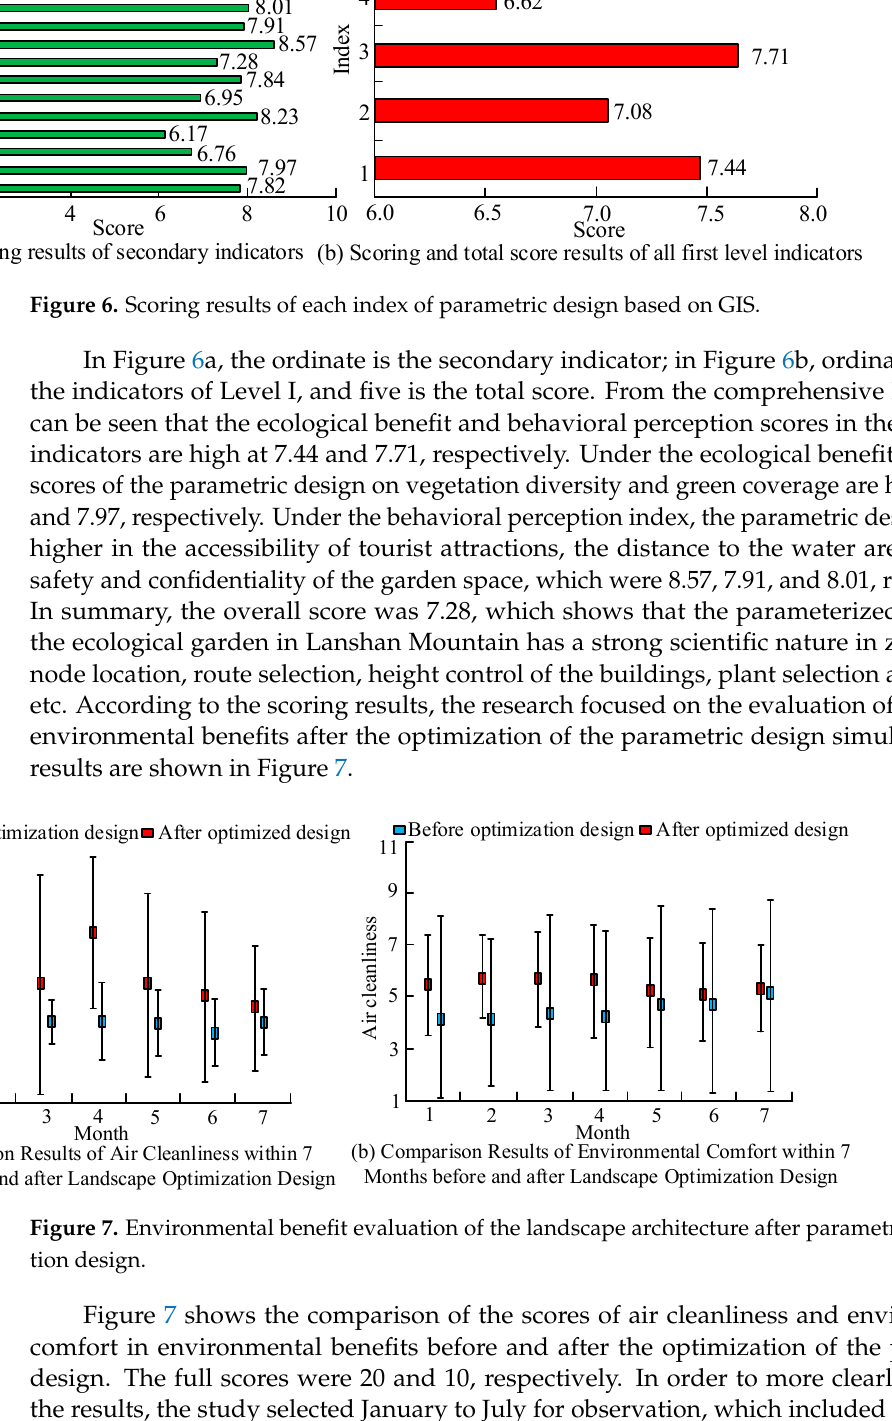
(b) Economic data of simulated and optimized gardens from 2018 to 2021 Figure 8. Economic benefits of the ecological garden in Lanshan Mountain after parametric design optimization. In Figure 8, X1–X5 represents current inflow, current outflow, the depreciation ex- pense of fixed assets, profit before interest and tax, and net profit, respectively. From Fig- ure 8a, it can be seen that the cash inflow in the first four years showed a growth trend, but it was relatively slow, reaching 685.94 million yuan in 2017, with a growth rate of 24.87%; net profit also showed a growth trend, reaching 414.3 million yuan in 2017. From Figure 8b, it can be seen that the growth was relatively rapid at this time, reaching 3.5795 billion yuan by 2021, with a growth rate of 78.92%. In summary, the depreciation cost of the fixed assets of the garden always remained at 68.32 million yuan, indicating that it was well-maintained and had a low wear rate. At the same time, the calculated return on in- vestment was 26.17%, which was more than the expected return of 20%, indicating that